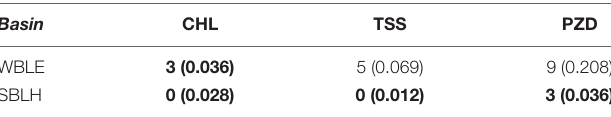
TABLE 3 | Wilcoxon signed-rank test statistics (W) and p -values (in parentheses) for the analyses comparing basin-wide median metric values from